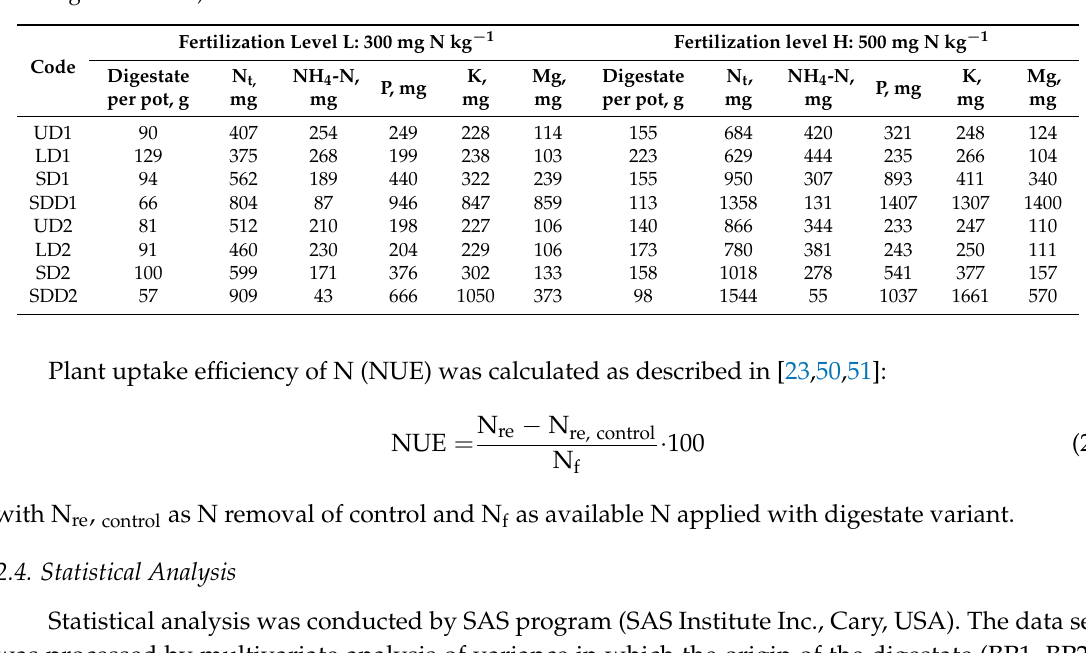
Table 4. Mass of digestate variant added to 1 kg of soil per pot to achieve calculated low (L) and high (H) N fertilization, i.e., 300 and 500 mg readily available N kg − 1 and resulting content of NH 4 -N, P, K and Mg in each pot (code of digestate variants 1 and 2 means biogas plant 1 and biogas plant 2 respectively, UD = untreated digestate, LD = liquid digestate, SD = solid digestate, SDD = solid digestate